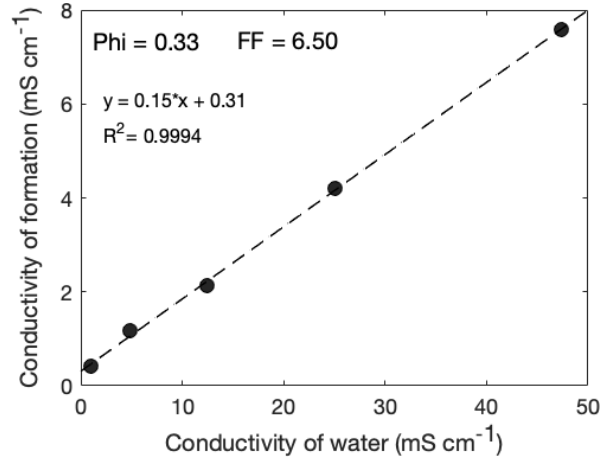
Figure 3. Sand sample conductivity as a function of water conduc- tivity for the Cottesloe Beach sample with a porosity of 33%. The slope of the linear correlation gives a formation factor (FF) of